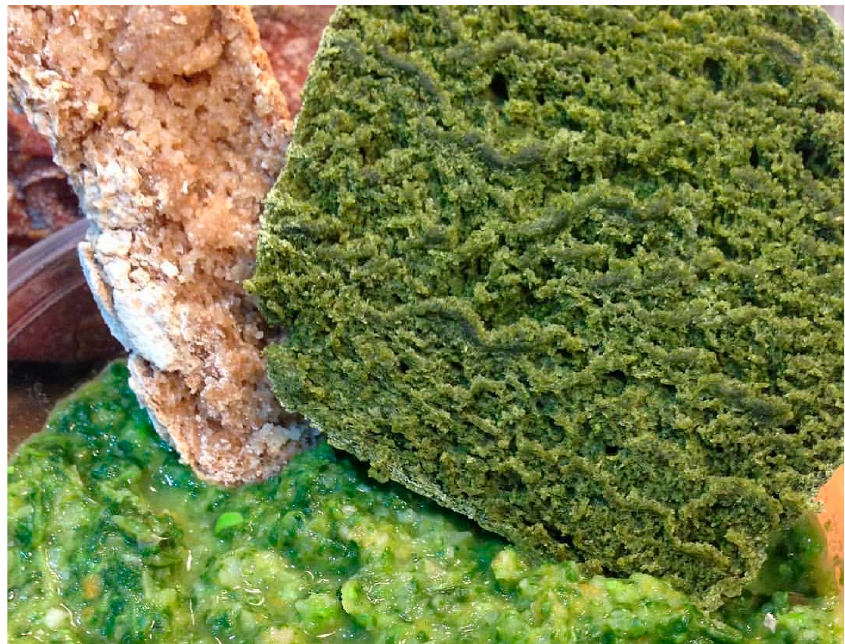
Figure 4. Hogweed bread. Picture and recipe by Eleonora Matarrese. The full recipe is available in the Supplementary Materials.